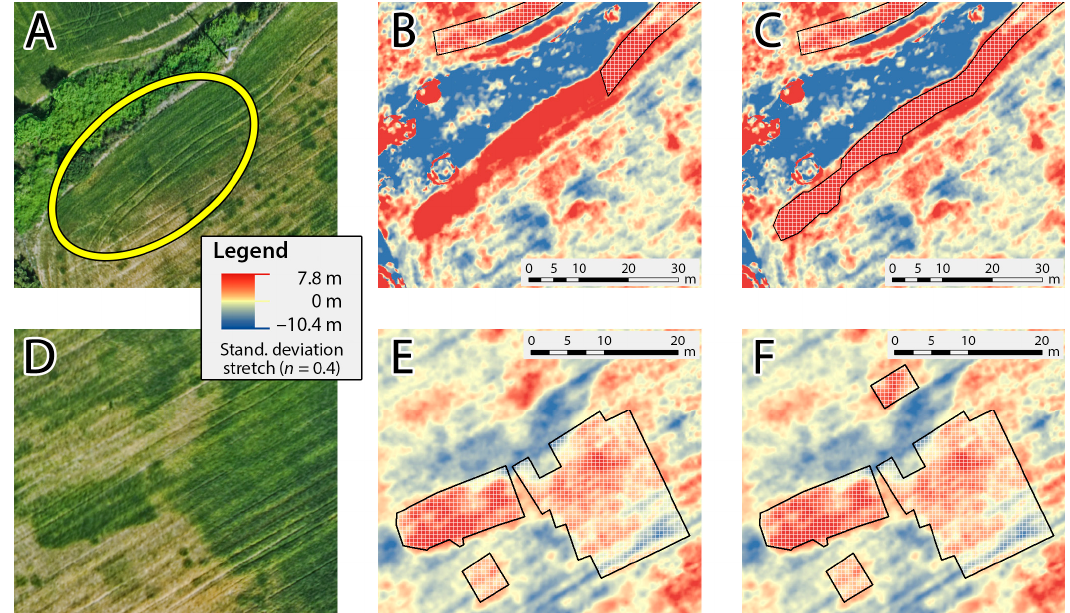
Figure 4. Two examples ( A – C and D – F ) that show the complementary nature of the orthophotograph and the LRMs. Both ( B ) and ( E ) show the initial mapping based on the optimised orthophotographs ( A ) and ( D ). After taking a LRM (annulus, [45, 75]) into account, features could be added ( F ) or enlarged ( C ).